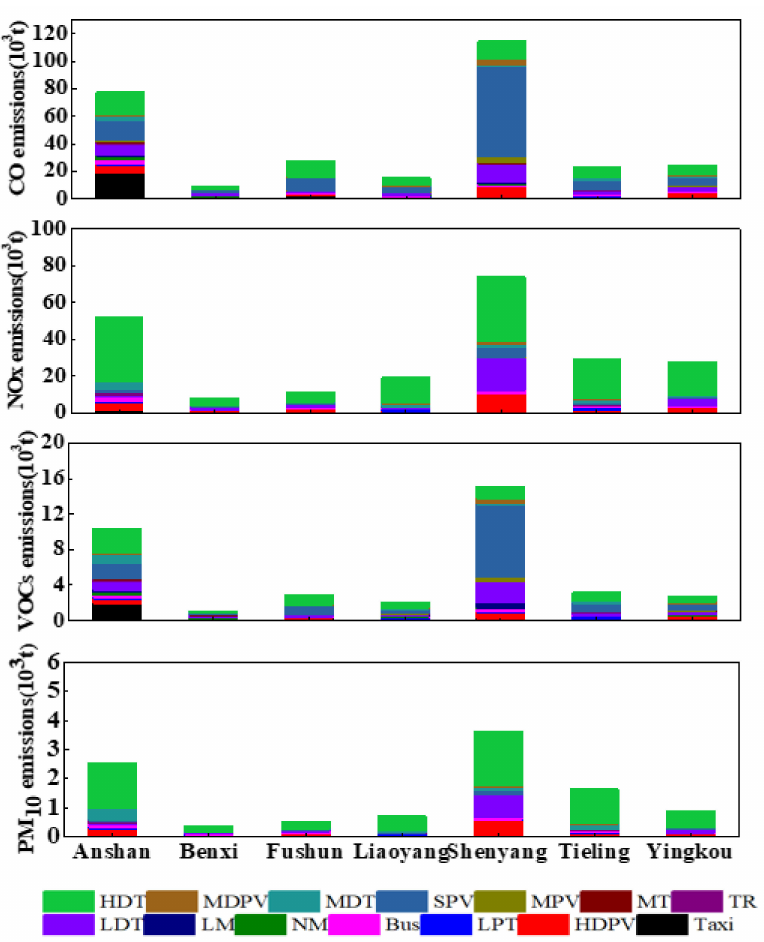
Figure 5. Emission intensity of different vehicle types in each city during